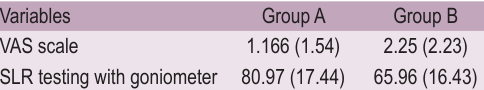
TABLE 4. Between-group change score after